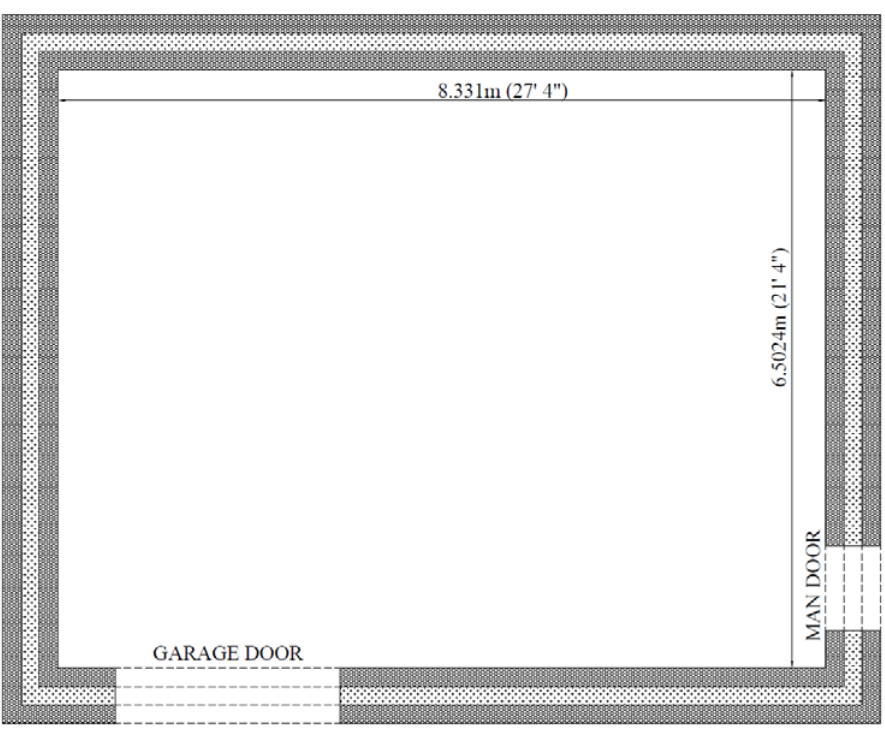
Figure 5. Lower floor layout of the home.